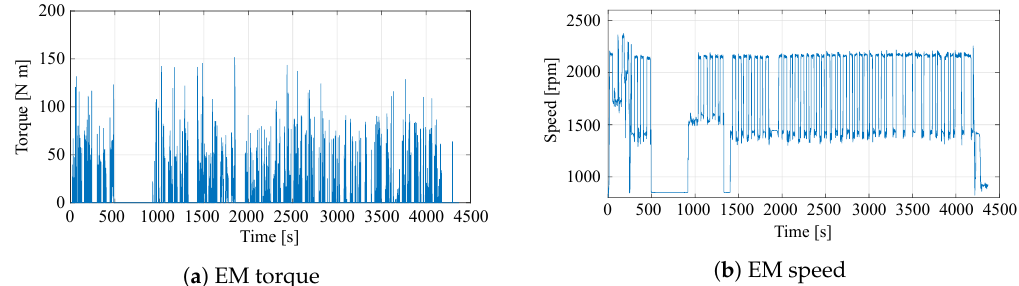
Figure 4. Performance requirements for the Electric Machine (EM) as a boost for the Internal Combustion Engine (ICE) when the tractor is operated in hybrid mode with a weeder instrument. The numerical data are available in [24].